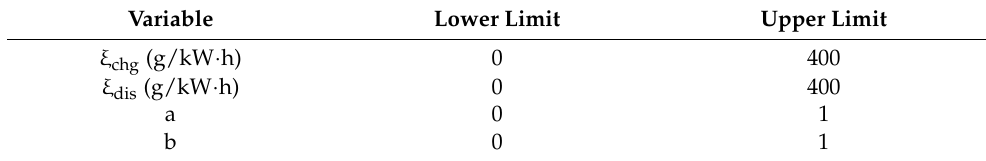
Table 6. The decision variables range of the particle swarm optimization (PSO) algorithm.